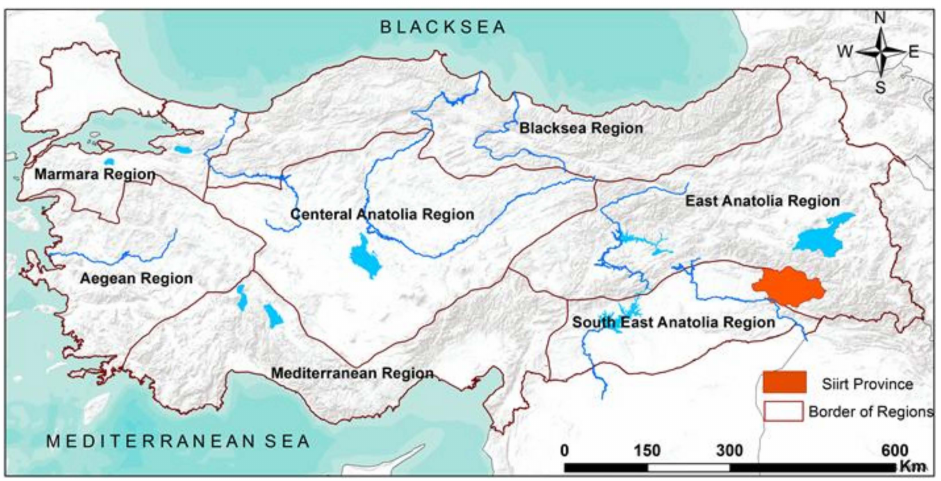
Figure 1. Research area location map (Siirt province is red-colored on